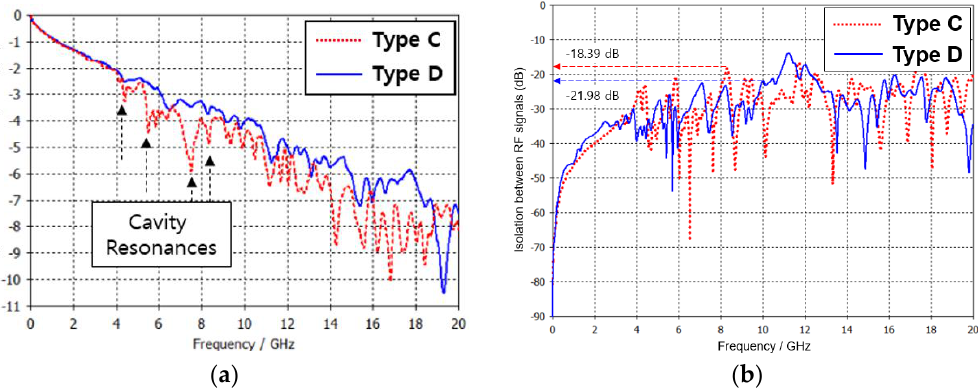
Figure 11. Simulation results of Type C and Type D with 158 mm long RF signal traces, using a CST MWS simulator. ( a ) Signal insertion loss and ( b ) Isolation between RF signals. Table 4. Whether each structural type met key requirements for mm-wave RF. In case of Type A, Type B, and Type C, the requirements for mm-Wave RF were not satisfied, as described in the yellow background of the table.